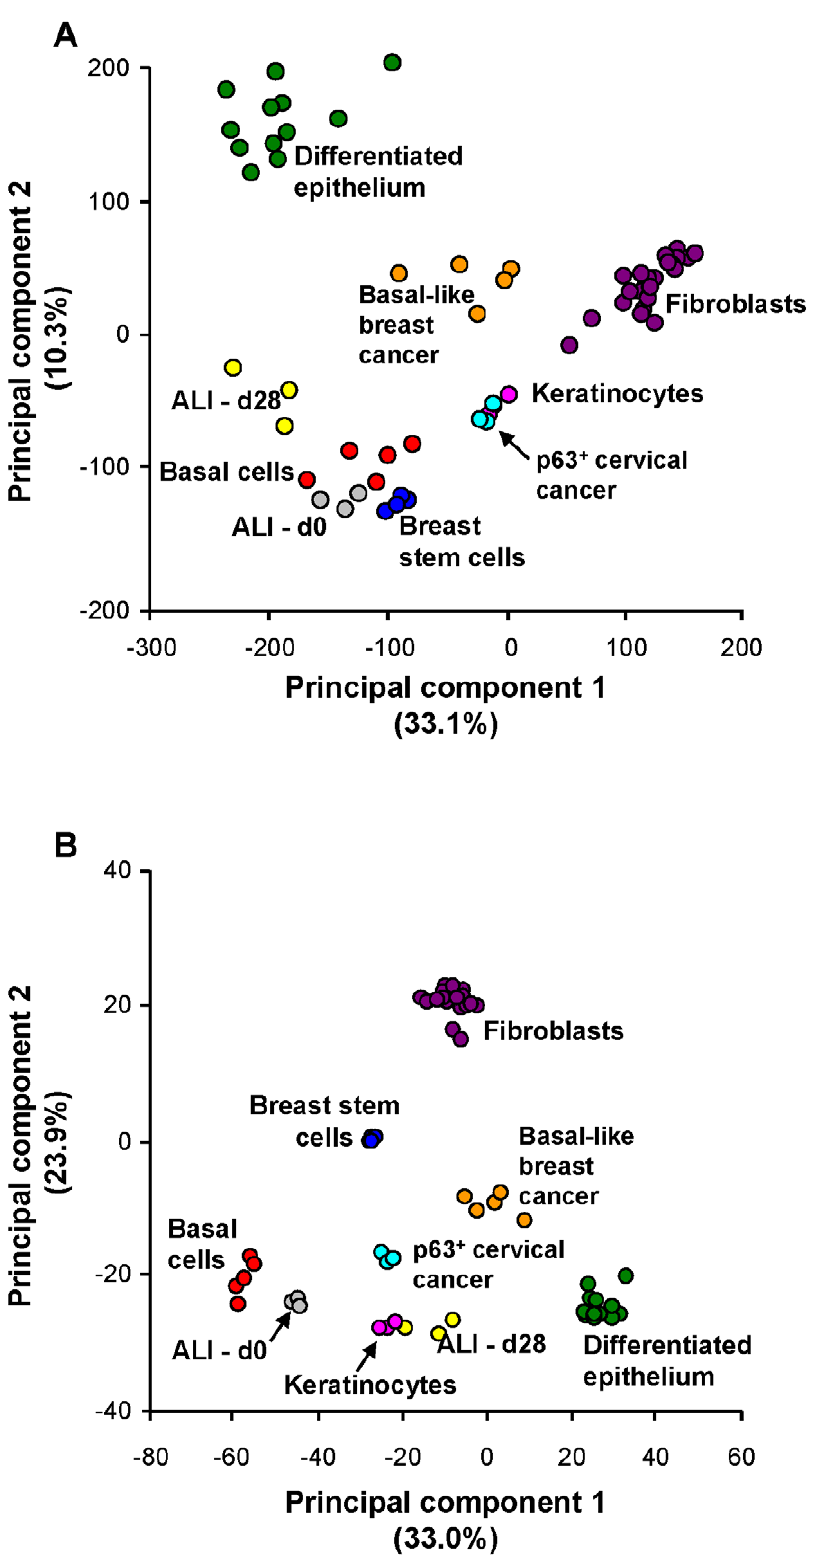
Figure 3. Principal component analysis-based comparison of airway basal cells to other human tissues and cells. Compared tissues and cell types were all of human origin and included: basal cells (human airway basal cells, red; n=5); differentiated epithelium (complete large airway epithelium obtained by brushing, green; n=12); ALI-d0 (basal cells cultured on ALI until confluent, , 2 days after plating (see Methods), grey; n=3); ALI-d28 (the same airway basal cells after 28 days of differentiation in air-liquid interface, yellow; n=3); breast stem cells (from Gene Expression Omnibus GSE15192: CD44 + CD24 2 stem-like fraction of MCF-10A immortalized breast epithelial cells, dark blue; n=4), basal-like breast cancer